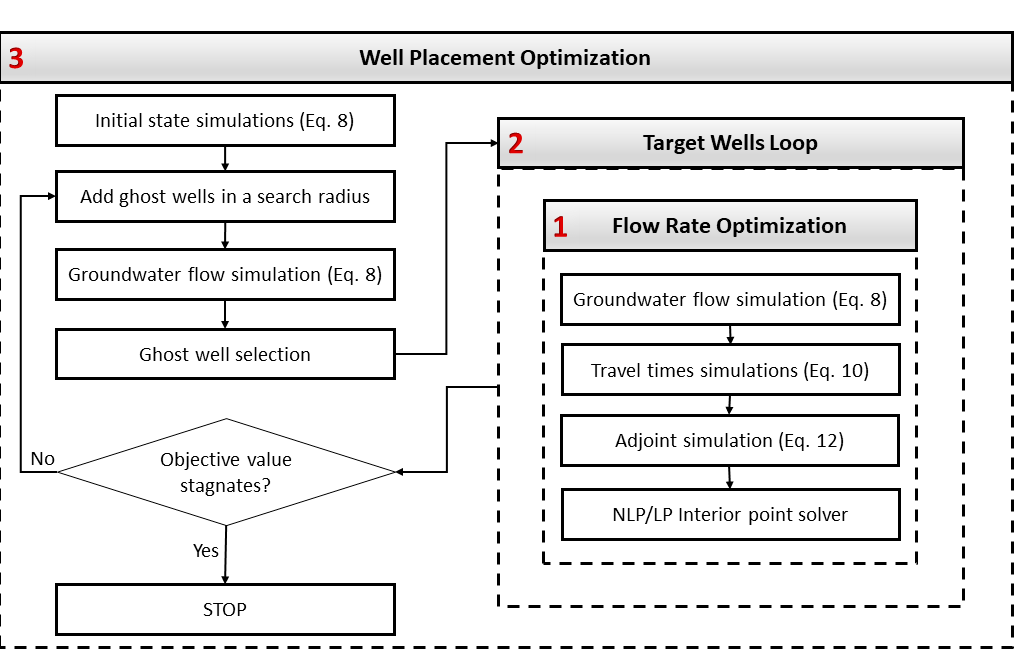
Figure 2. Simplified flowchart of the surrogate-based simulation-optimization approach introduced in this paper. The algorithm has three nested levels for: (1) flow rate optimization of a single well; (2) looping over all target wells; (3) well placement optimization. At each level, major sub- steps of the algorithm as described in sub-sections 2.2 to 2.5 are listed. Solved equation systems at these sub-steps are indicated when